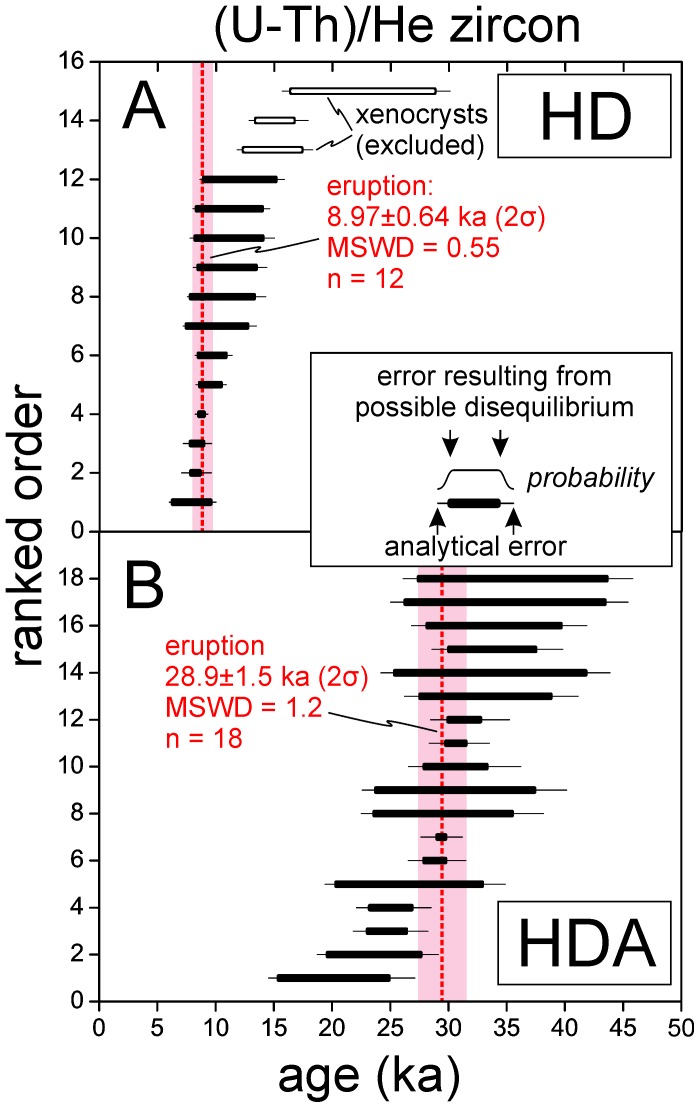
Ranked order plots for disequilibrium-corrected (U-Th)/He zircon ages for Hasan Dağı.Individual eruption ages (red dashed lines) for samples HD (A) and HDA (B) were calculated as error-weighted averages from (U-Th)/He zircon analyses. Errors comprise analytical uncertainties plus the uncertainty for the disequilibrium correction, and are bracketed by secular equilibrium (minimum age), and the disequilibrium-corrected age that corresponds to the measured U-Th rim crystallization age, assuming that it represents the crystallization age for the entire crystal (maximum age). Zircon crystals where rim ages are in (near-) secular equilibrium thus have the lowest uncertainties. Three crystals in sample HD yield (U-Th)/He ages that are too old to be reconciled with the average of the population. We interpret them as xenocrysts from pumice of older eruptions, and thus excluded them from the average. Weighted average age errors account for systematic and analytical uncertainties, and are quoted at 2σ; error bars plotted at 1σ.